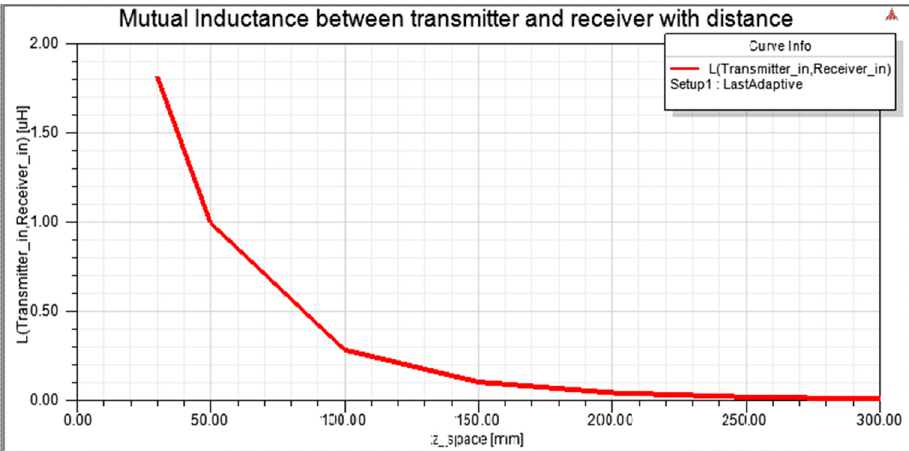
Figure 6. Mutual inductance between transmitter and receiver coils.